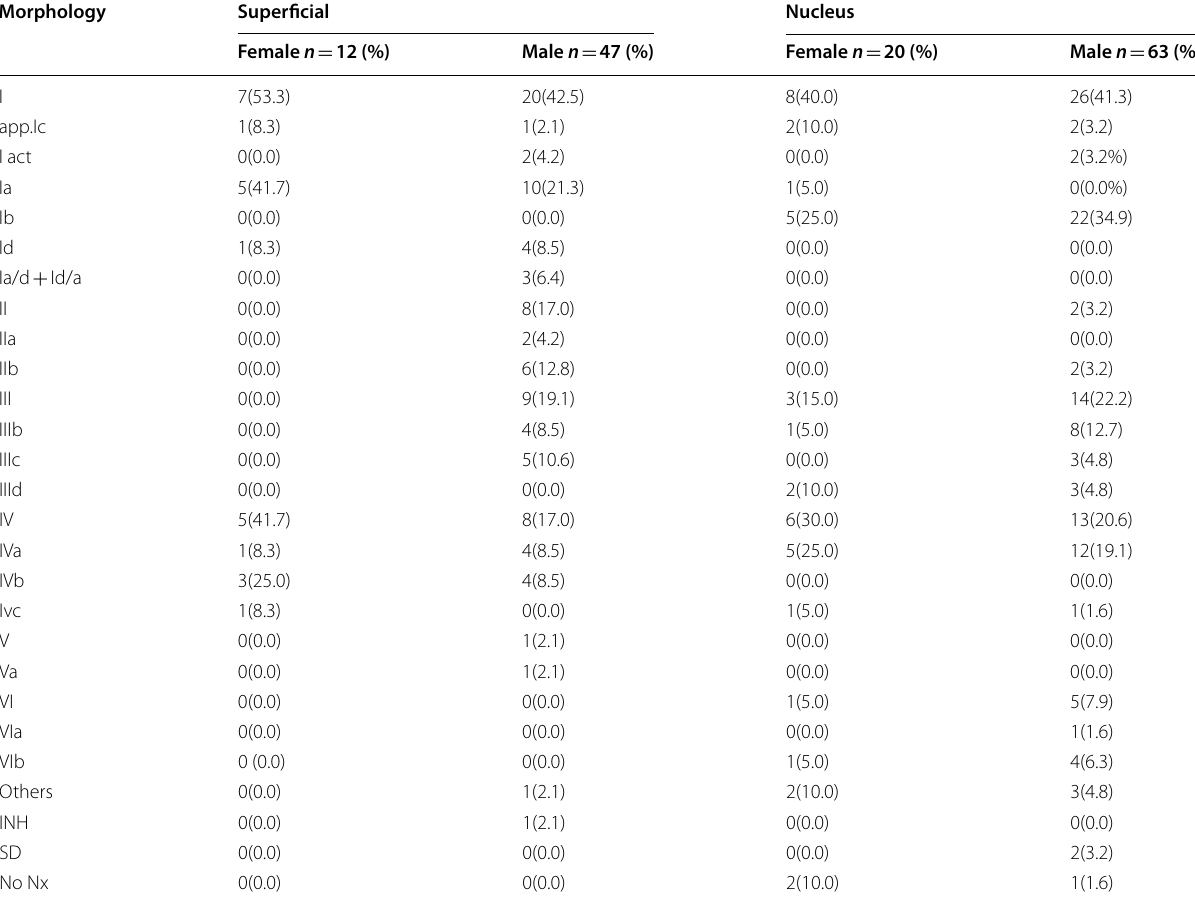
Table 3 Simple morphological types of urinary stones by sex